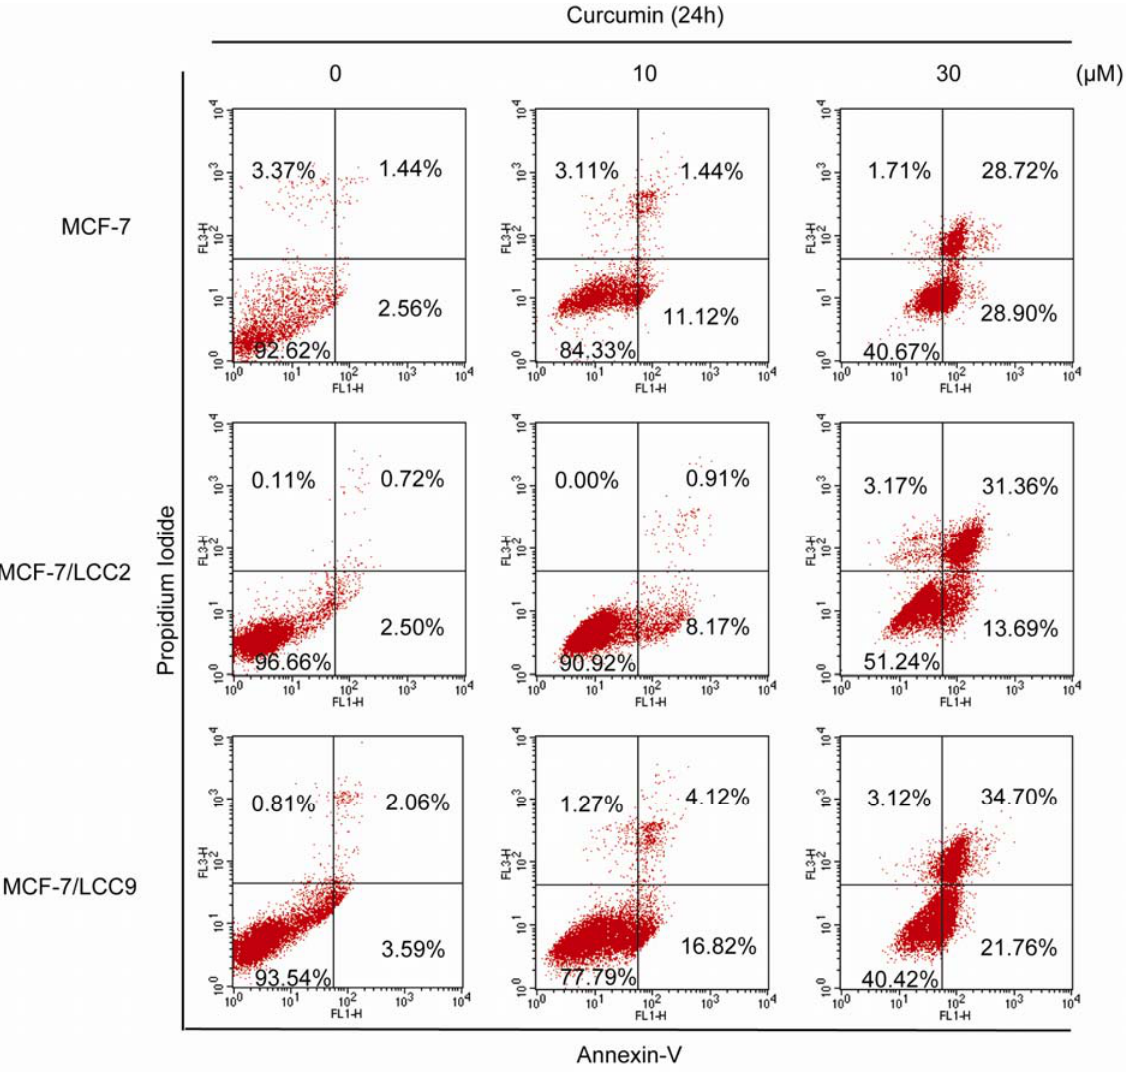
Figure 2. Curcumin induces apoptosis in MCF-7/LCC2 and MCF-7/LCC9. Cells were incubated with curcumin (10 and 30 μ M) for 24 h, followed by staining with Annexin-V/PI. The lower right quadrant (Annexin-V+/PI − ) and upper right